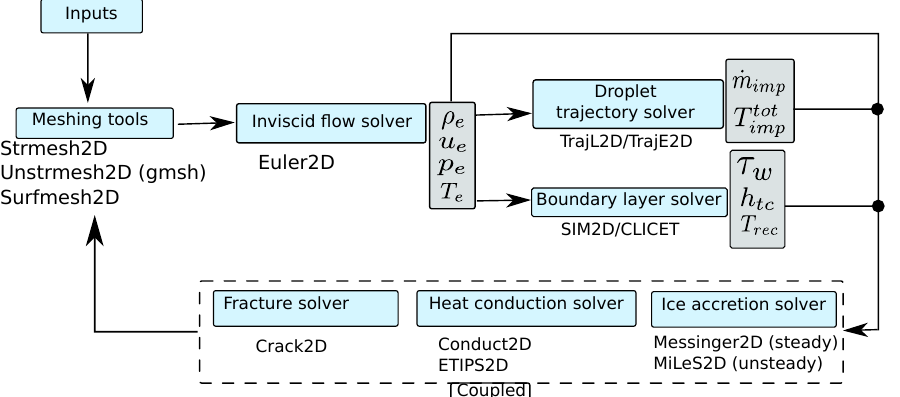
Figure 3. The architecture of the IGLOO2D icing suite developed at ONERA. The work presented in this article focuses on the computation of the boundary layer, the ice accretion solver, and the heat conduction